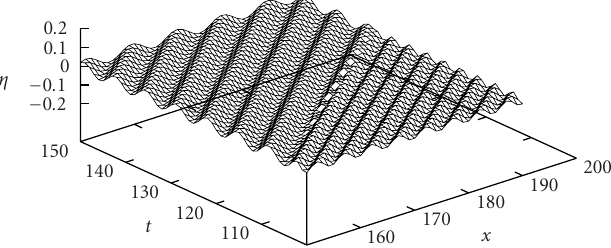
Figure 5.6. Wave motion due to initial displacement when t = 100 to 150, x = 150 to 200; (cid:1) = 0 . 01, D = 0 . 5.